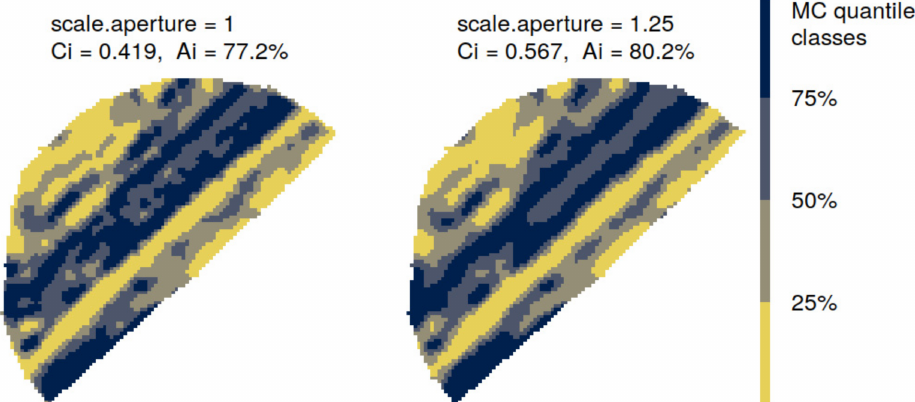
Figure 10. Quantile-based categorical maps of FRK MC interpolations at 2 different scale apertures, with computed aggregation index ( Ai ) and contiguity index ( Ci )